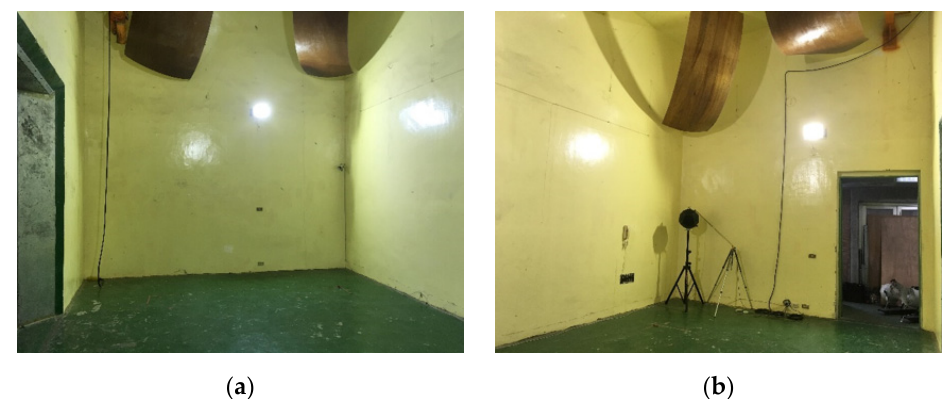
Figure 3. Picture of reverberation room: ( a ) from position A; ( b ) from position B.